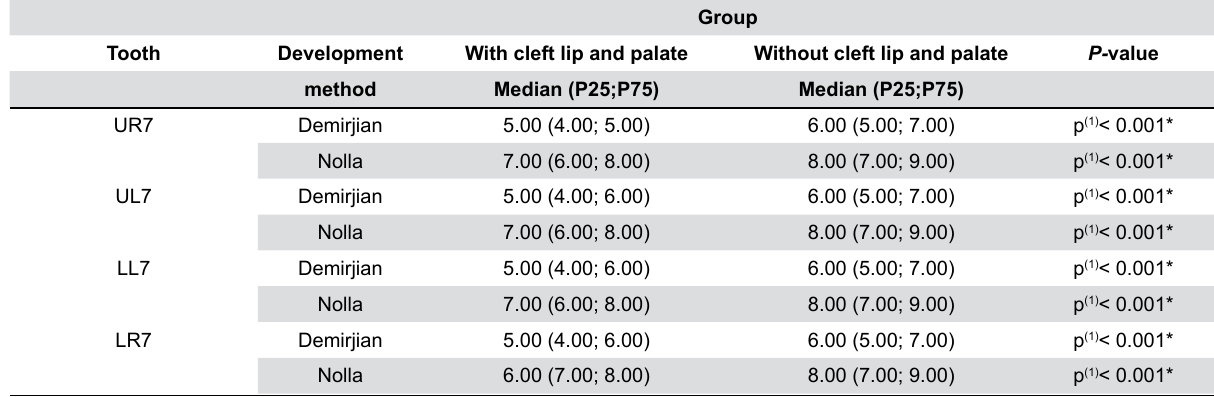
Table 3- Analysis of the development stages of permanent second molars in individuals with or without cleft lip and palate, according to the classification method, using Wilcoxon’s test for paired data